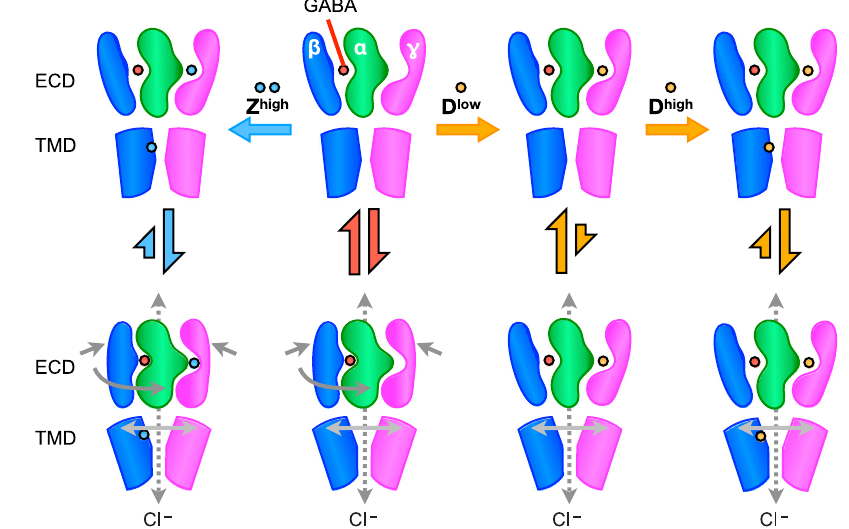
Fig. 6 | Proposed mechanism of DMCM/Zolpidem activity. Upon binding of the orthosteric agonist GABA, the structure transitions to an open conformation through a motion that involves the ECD ’ s contraction and rotation, which then triggers the opening of the closed activation gate. This transition to the open conformationisfurtherstabilizedbythebindingofPAMzolpidemtoboththeECD and TMD domains. The NAM DMCM at low concentrations binds to the ECD and stabilizes the twisted and expanded ECD conformation to preclude pore opening. However, at high concentrations, DMCM binds at both ECD and TMD sites to facilitatechannelopeningdespiteatwisted andexpanded ECDconformation.ECD